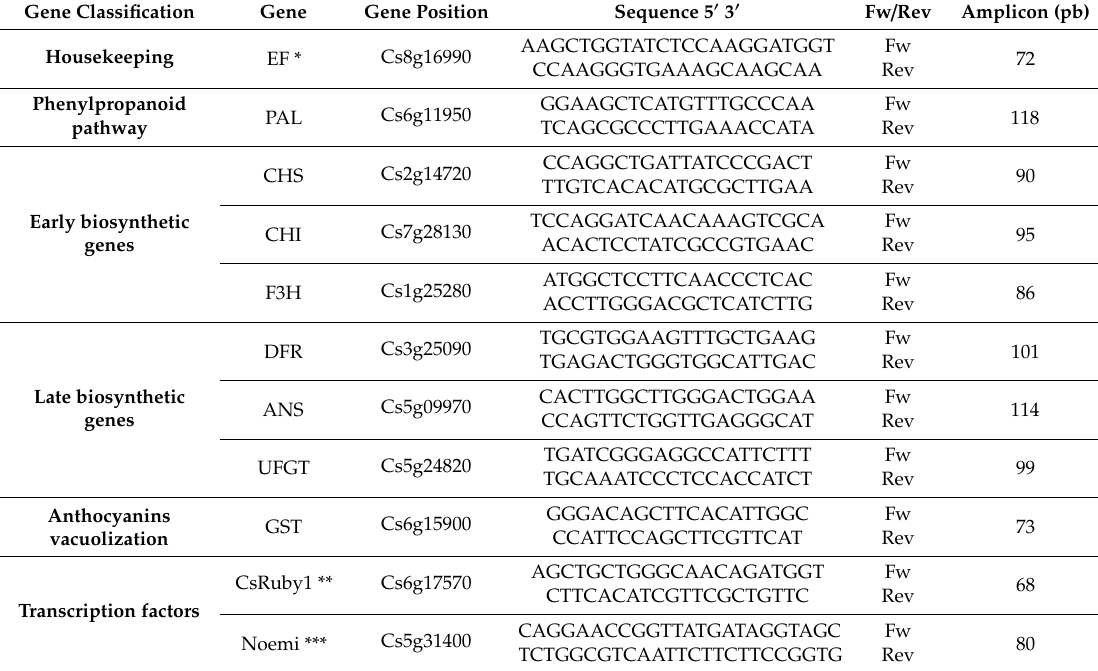
Table 2. Characteristics of primers used for qRT-PCR analysis. Asterisks indicate that primers